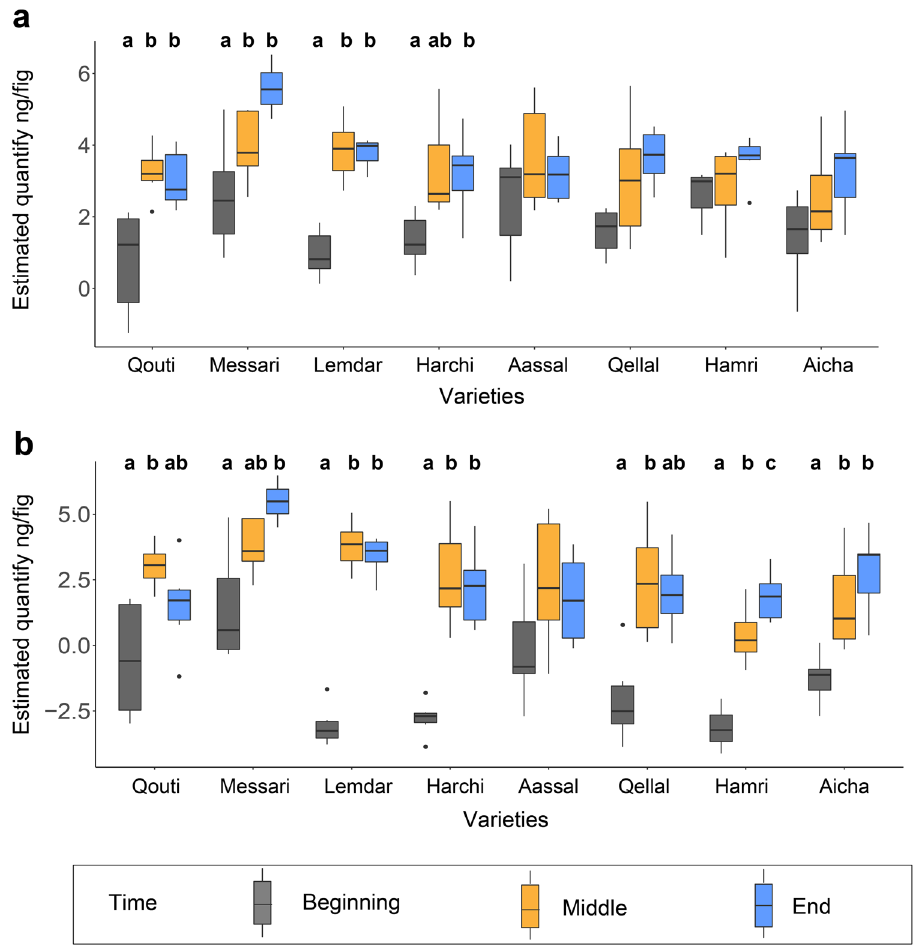
Figure 4. Comparison of the estimated quantities of all volatile organic compounds (VOCs) ( a ) and of the four VOCs responsible for pollinator attraction ( b ) at the three different times within the manual pollination period for each of the eight varieties. Data were log-transformed. Results of pairwise comparisons of estimated total quantifies within each variety using least-squares means comparisons are presented, with different letters indicating statistically significant